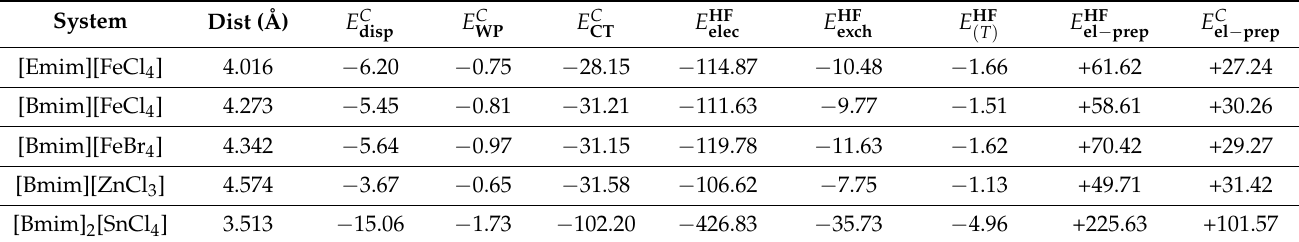
Table 2. Contributions to the interaction energy (kcal mol − 1 ) using DLPNO-CCSD(T). Dist stands for the distance of the minimum interaction energy between the CM. E C from weak pairs, E C for the charge transfer contribution, E HF CT contribution, E HF for the contribution from triple excitations, E HF ( T ) E C for the correlation preparation el − prep